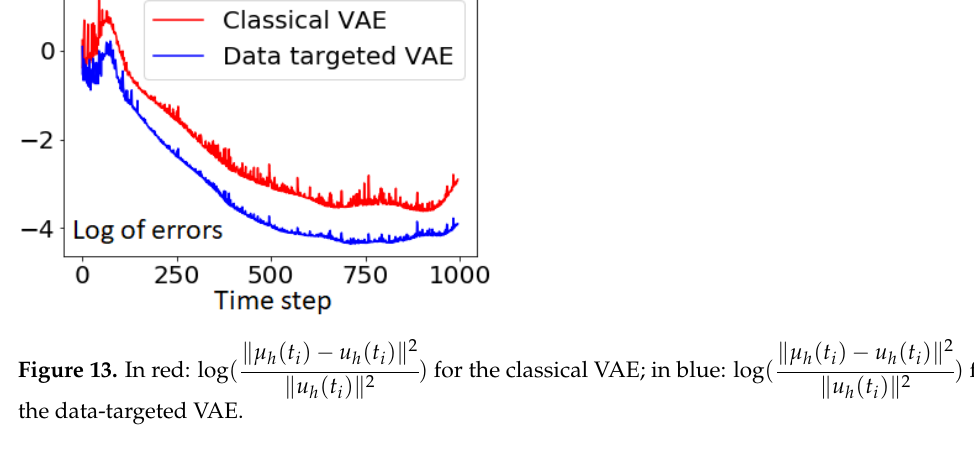
Figure 13. In red: log ( the data-targeted VAE.